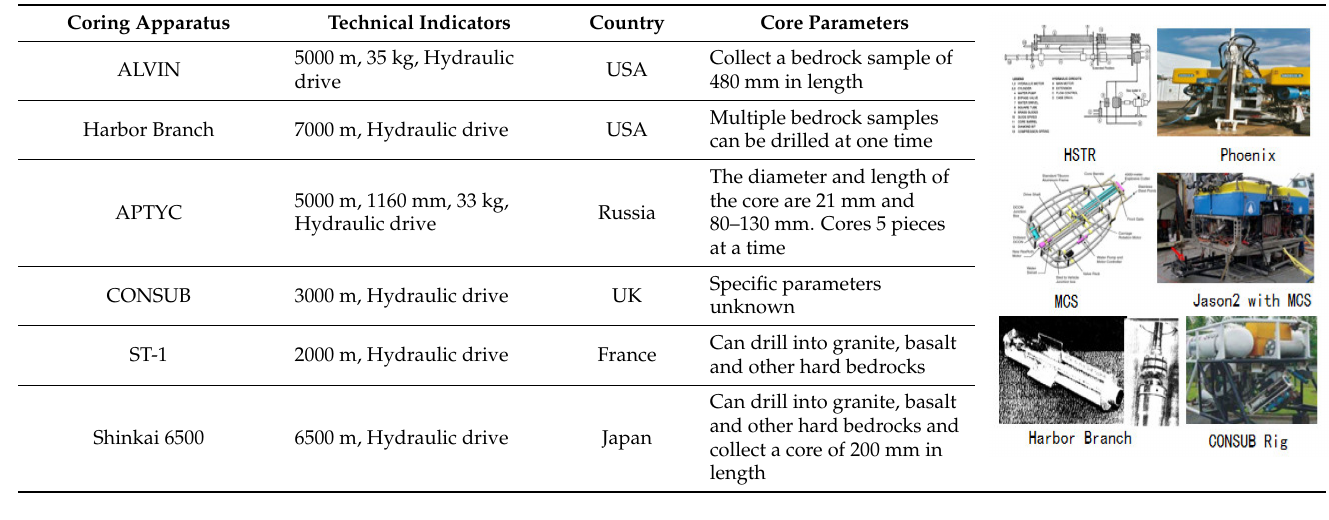
Table 1. Development status of lightweight drill systems for use by a submersible.